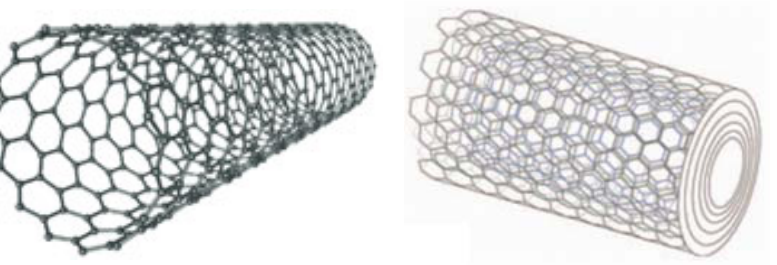
Figure 1. Illustration of SWCNTs (left) and MWCNTs